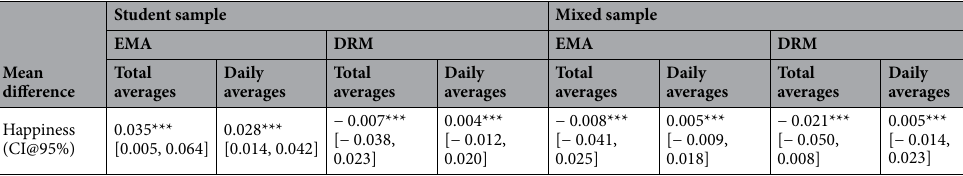
Table 2. Mean of pairwise differences between average reported SWB (happiness intensity × duration) with duration weights and average happiness without duration weights, with confidence interval at 95% level. Significant results mean that mean difference is less than 1%. (***if p val < 0.001;**if p val < 0.01) (see Supplementary Materials, Table Table S13 for